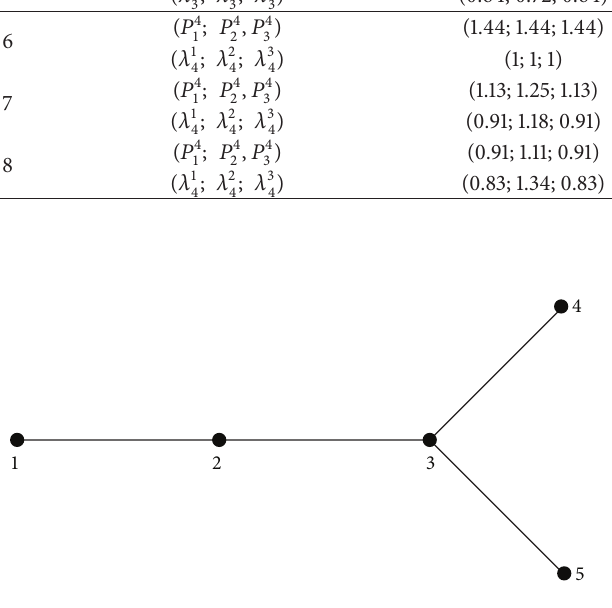
Figure 3: Competition of players on a